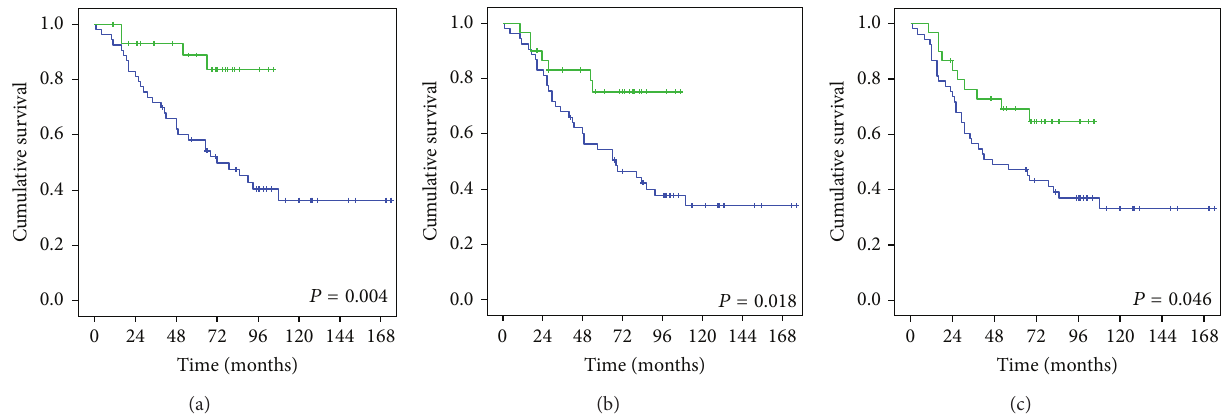
Figure 1: Comparison of (a) the 5-year overall survival, (b) the 5-year locoregional-free survival, and (c) the 5-year disease-free survival in T4-locally advanced NPC patients treated using IMRT (green line) or using 3D-CRT (blue